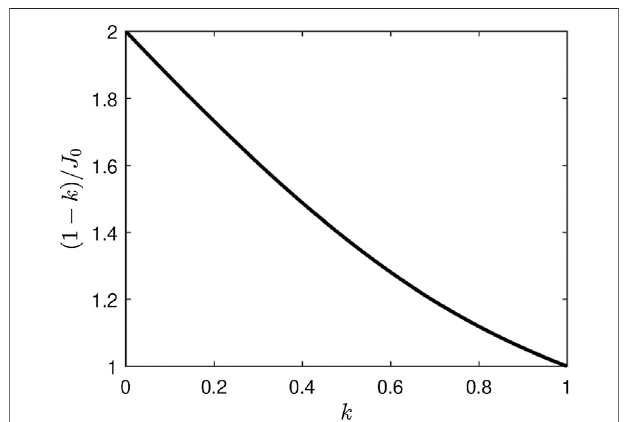
FIGURE C1 | The ratio ( 1 − k ) / J 0 ( k ) as a function of k .